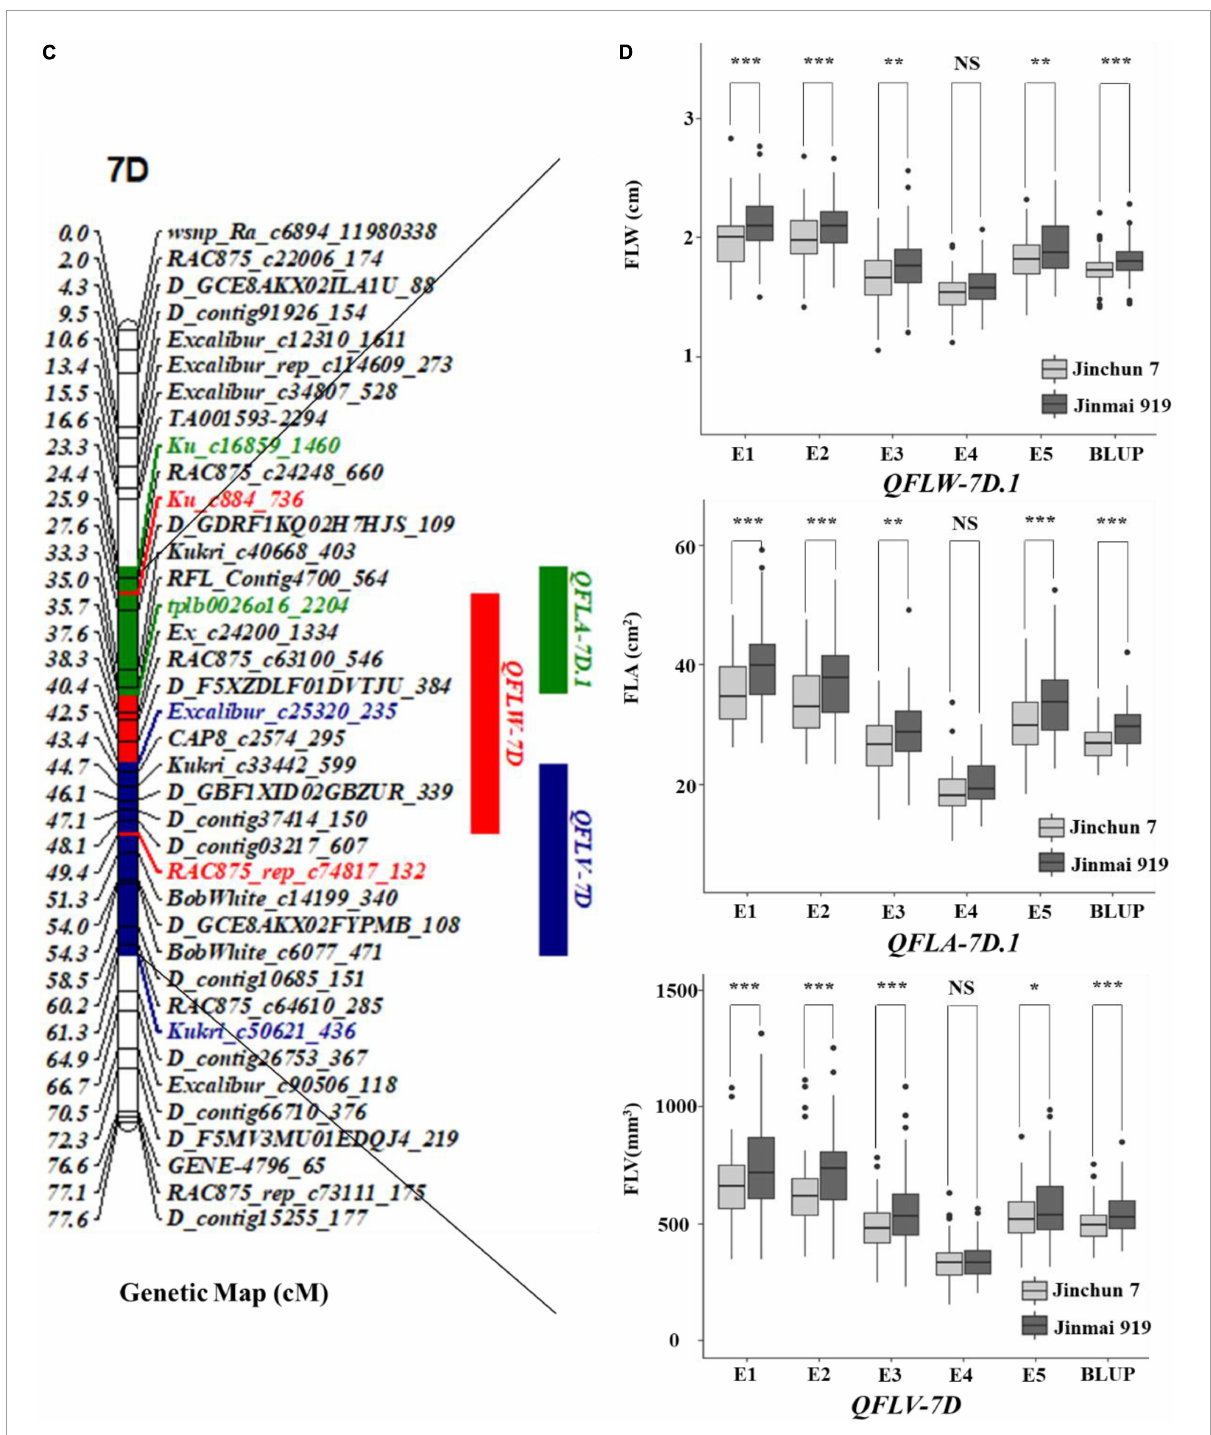
FIGURE3 Genetic map of the major QTL QFLW-7A.1 , QFLA-7A.1 , QFLW-7D , QFLA-7D.1 , QFLV-7D , and their effects. (A,C) Genetic map of 7A and 7D; (B,D) box plots of the effects of QTL on FLW, FLA, and FLV calculated after grouping the Jinchun 7 × Jinmai 919 DH population into two classes based on the allele of the flanking marker. *, **, and *** represent significance at P < 0.05, P < 0.01, and P < 0.001,